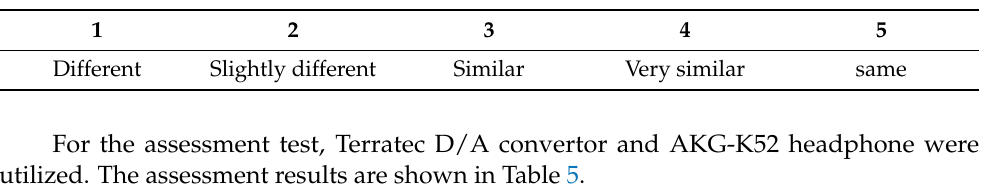
Table 4. MOS grades for the 1st step DoM assessment.